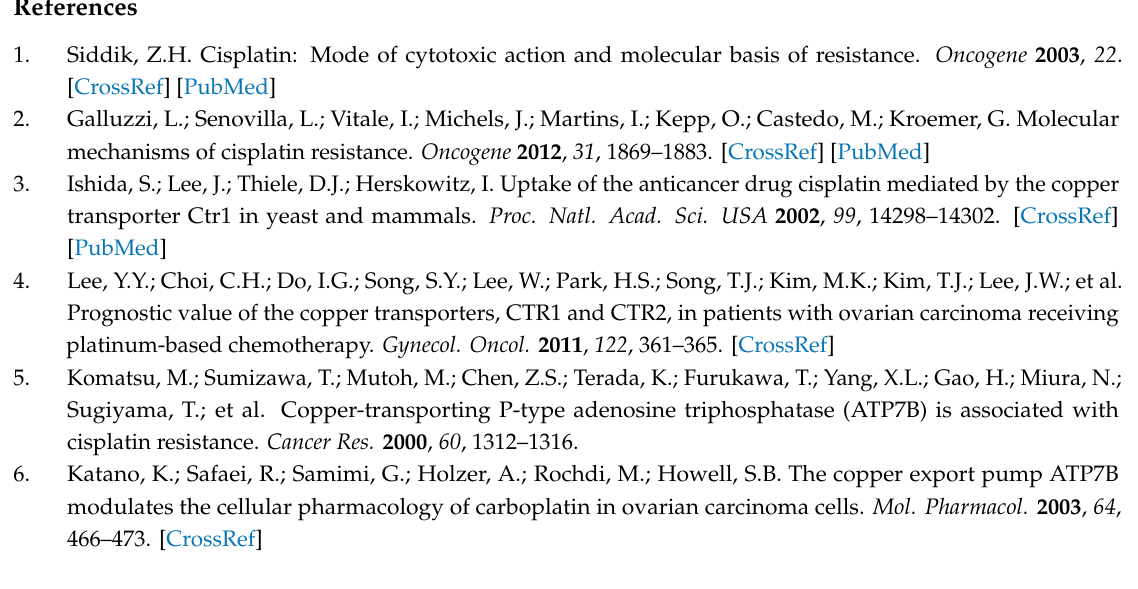
Figure S1: Characterization of ovarian cancer cell lines, Figure S2: Controls for HTS set-up, Figure S3: Dose response of IGROV-CP20 cells to the FDA drugs that emerged from HTS analysis, Figure S4: Impact of drug hits on Pt-resistant and Pt-sensitive ovarian cancer cell lines, Figure S5: Drug hits do not a ff ect Cu-dependent tra ffi cking of ATP7B and cisplatin toxicity in hepatic cells, Table S1: Gene ontology enrichment analysis of genes that were downregulated by Tranilast in cisplatin-treated IGROV-CP20 cells, Table S2: Gene ontology enrichment analysis of genes that were downregulated by Amphotorecin B in cisplatin-treated IGROV-CP20 cells, Table S3: Gene ontology enrichment analysis of genes that were downregulated by Telmisartan in cisplatin-treated IGROV-CP20 cells, Supplementary Dataset S1, Supplementary